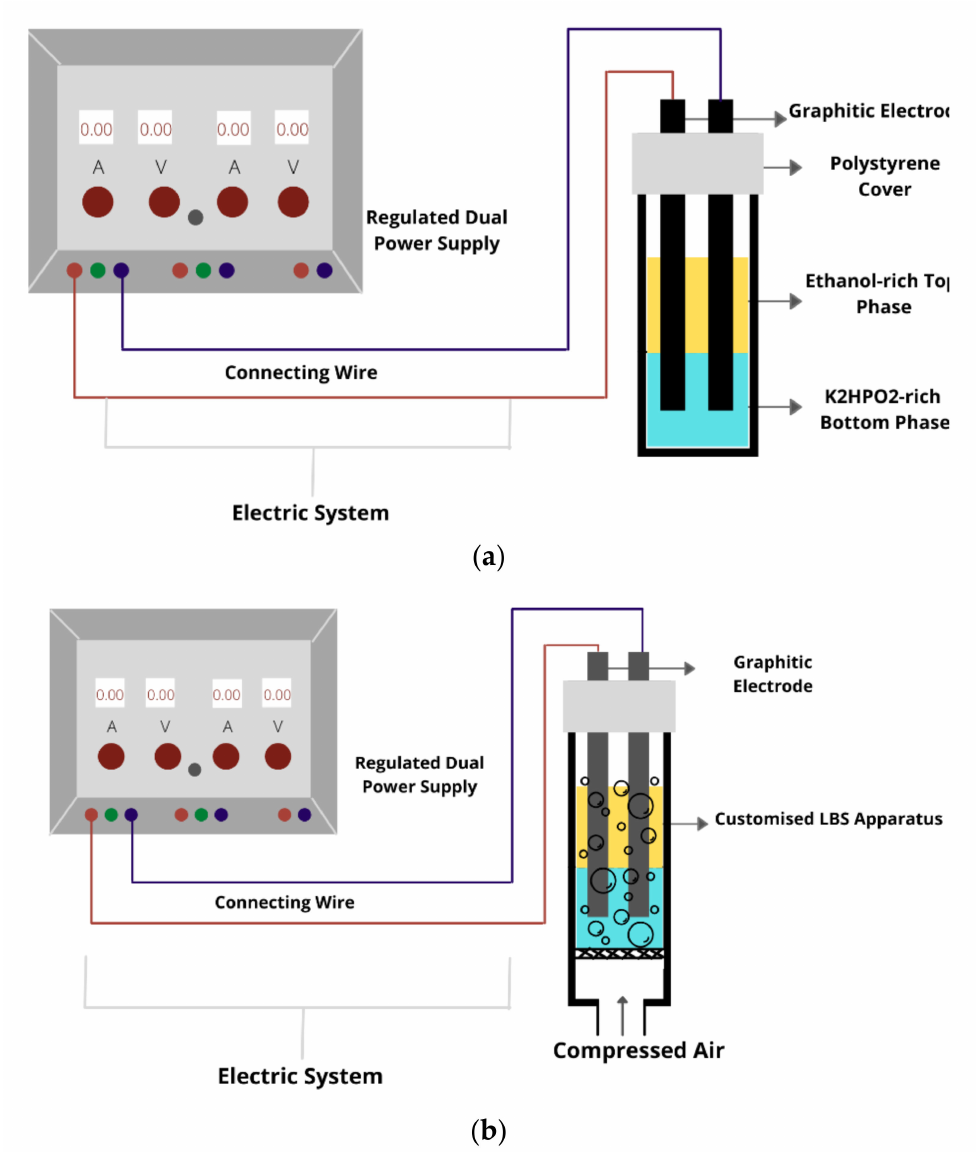
Figure 3. ( a ) The schematic diagram of the liquid biphasic electric partitioning system and ( b ) the liquid biphasic electric flotation